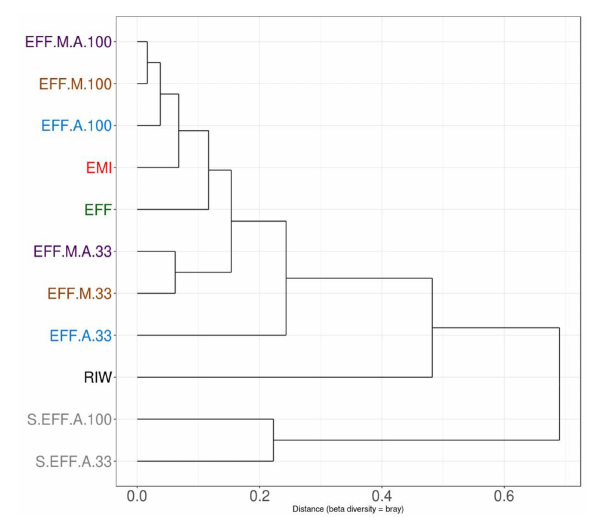
FIGURE 8 | Clustering of samples using Bray Curtis distance matrix from functional abundance. A similar relationship is seen compared to the taxonomic profile where all diluted samples clustered together. The major difference here the EMI sample clustering with the EFF sample indicating the similarity of functional profile despite the dissimilar taxonomic